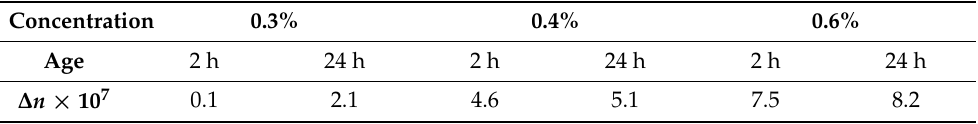
Table 1. Spontaneous optical anisotropy of composite agarose gels at λ 0 = 650 nm with different agarose concentrations at a constant concentration of purple